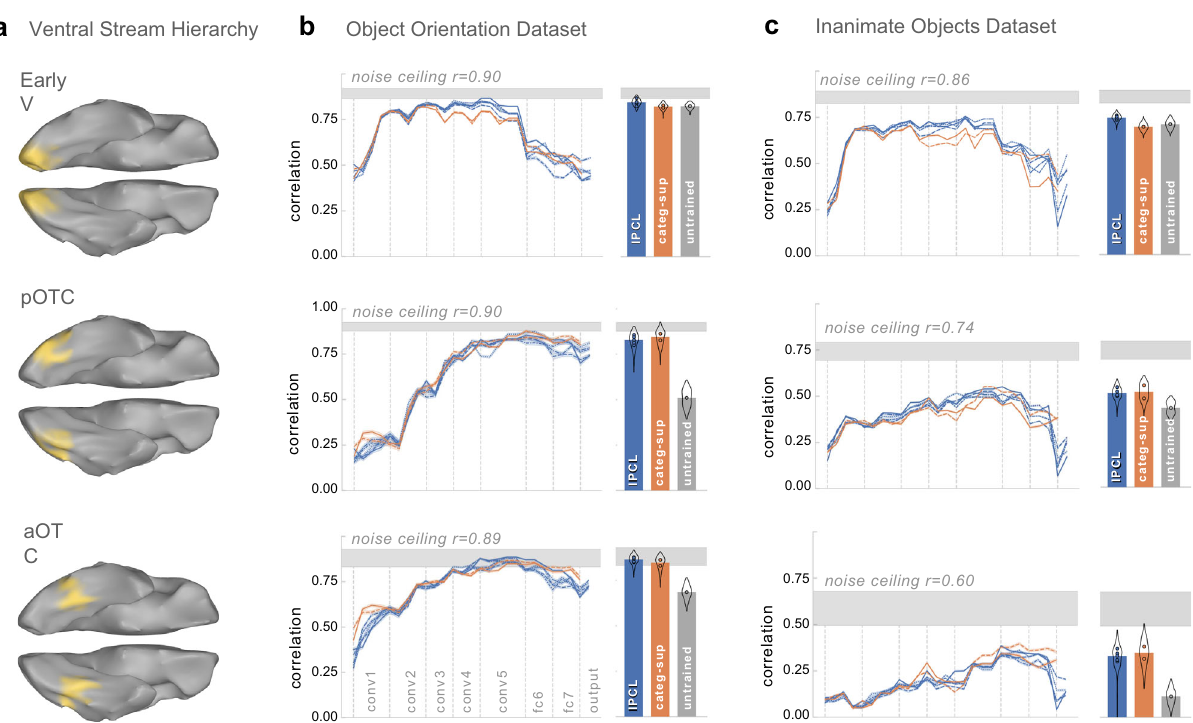
Fig. 2 Model-to-brain fi ts. a Visualization of the ventral stream regions of interest spanning the visual hierarchy from posterior to anterior (EarlyV, pOTC, aOTC). b and c show the veRSA results for the Object Orientation and Inanimate Object datasets, respectively. Each panel plots the mean correlation between model RDMs with neural RDMs (y-axis), averaged over split-halves of the brain data, shown separately for each model layer (x-axis) and brain region (rows). All IPCL models are in blue, and category-supervised models are in orange. The thickness of each line re fl ects 95% con fi dence intervals based on 1000 bootstrapped samples across split-halves. Bar plots show cross-validated estimates of the maximum correlation across model layers for each model class (IPCL in blue, category-supervised in orange, and an untrained model in gray). Error bars re fl ect a mirrored density plot (violin plot) showing the distribution of correlations across all split-halves, aggregated across instances of a given model type. Distributions are cutoff at ±1.5 IQR (interquartile range, Q3-Q1). Source data are provided as a Source Data fi